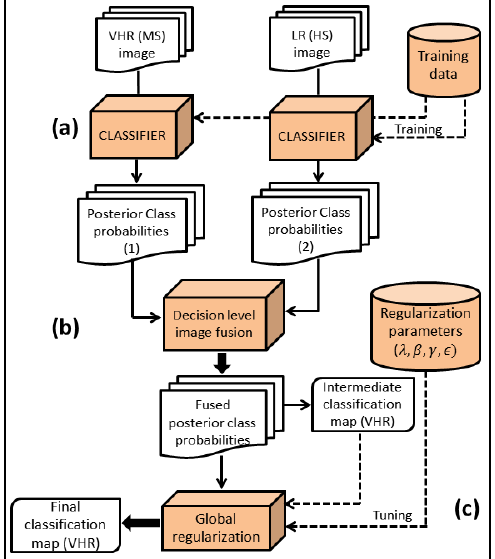
Figure 1. Two-step strategy for multi-sources data